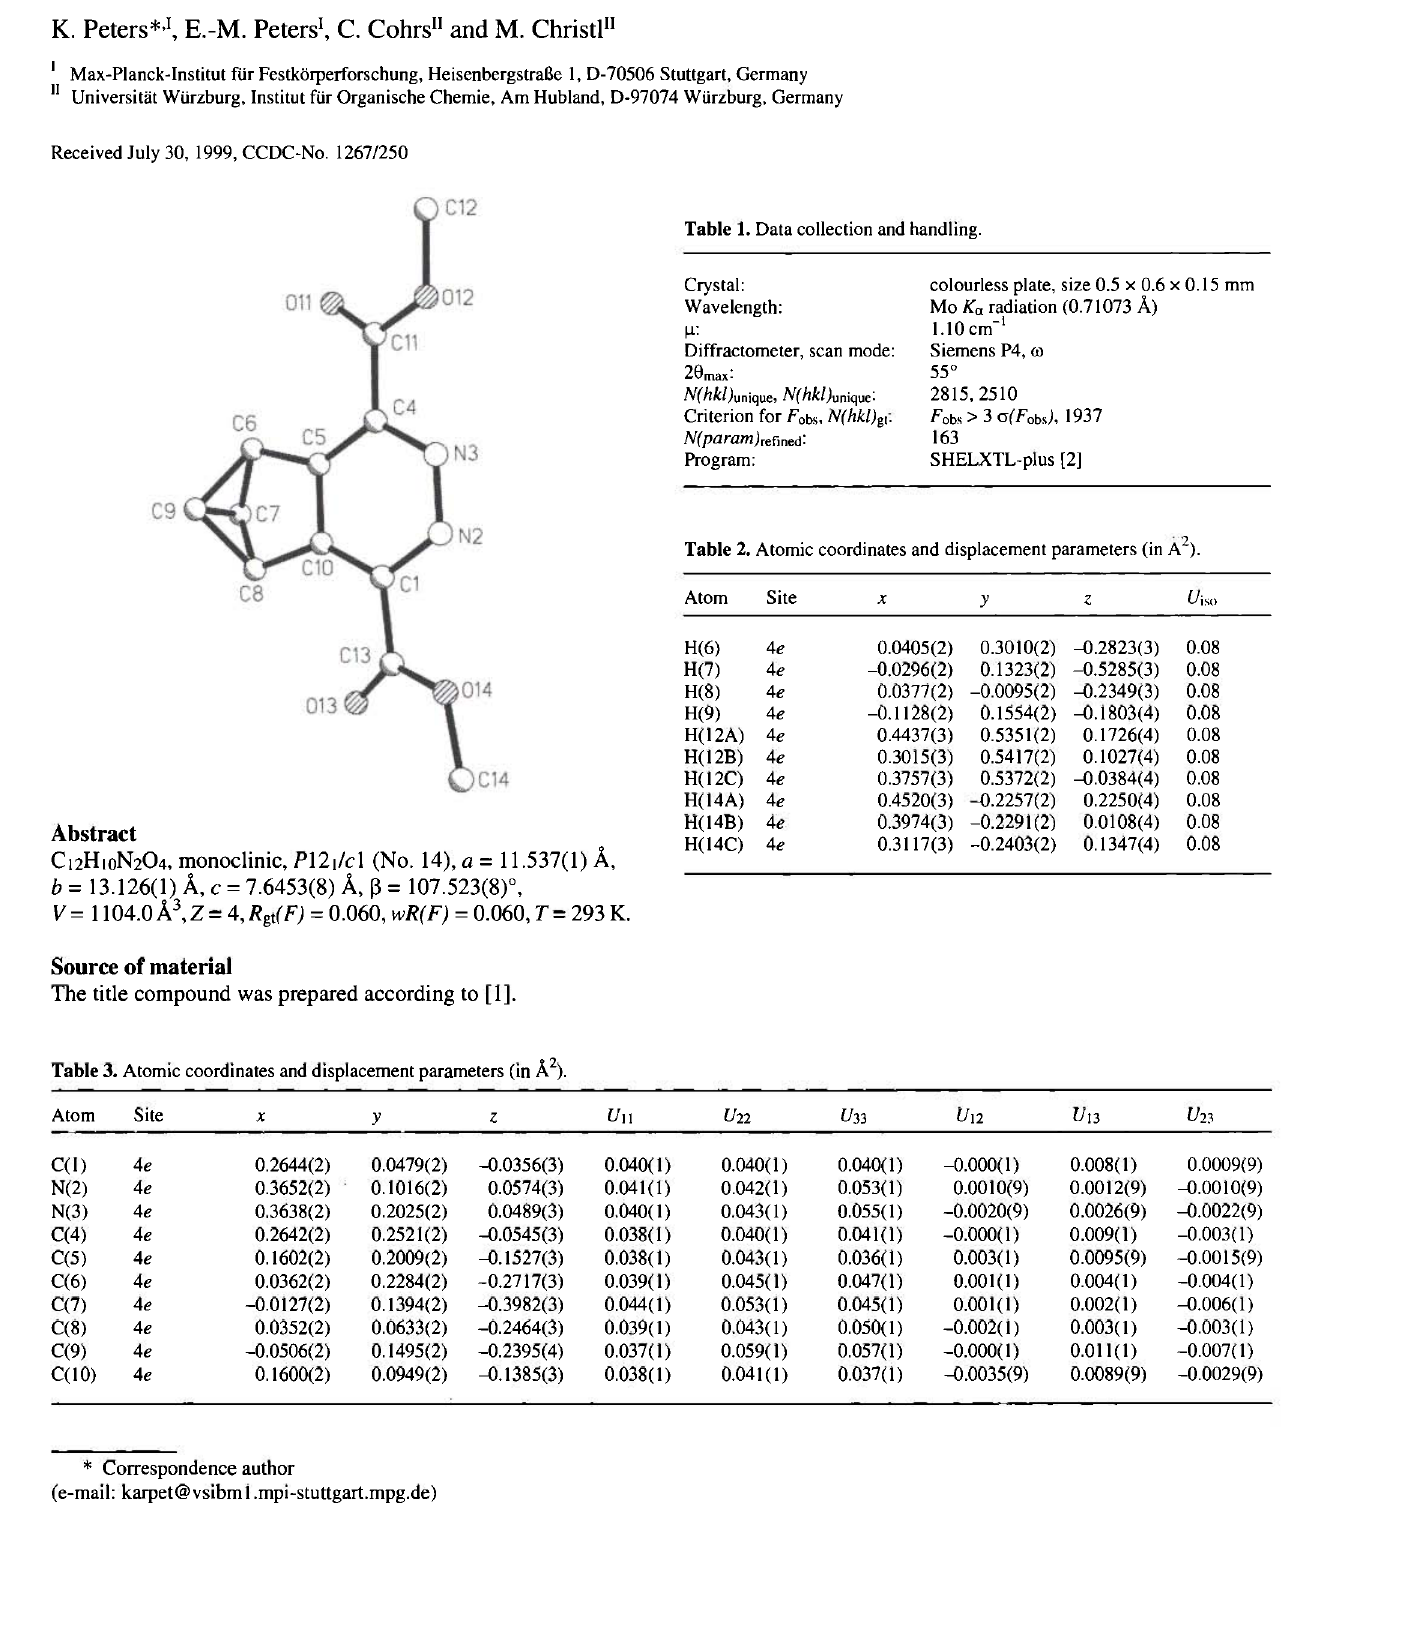
Table 1. Data collection and handling.